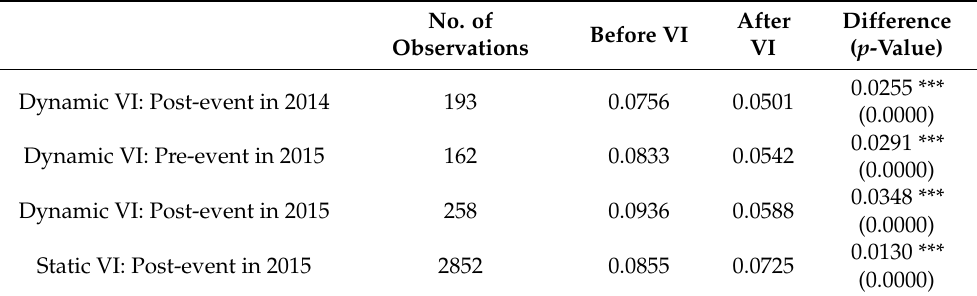
Table 2. Reduction in intraday volatility after VI occurrence. This table presents the results of comparing the intraday volatility during one hour before the VI occurrence (“Before VI”) with that during one hour after the VI occurrence (“After VI”). Within the given one hour (before or after the VI occurrence), we observe the highest ( High ) and the lowest price ( Low ) of the given stock and + Low } . For this analysis, we use stocks that calculate the intraday volatility by ( High − Low ) / { High 2 experienced at least one VI occurrence and were traded more than once between 10:00 and 14:00. The rightmost column (“Difference”) presents the volatility difference between Before VI and After VI. The positive number implies that the intraday volatility is reduced after the VI occurrence. *** denotes 1% statistical